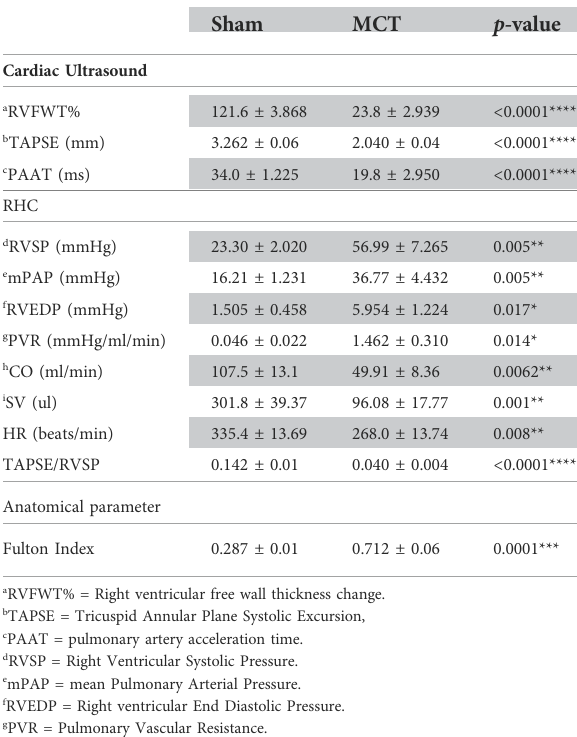
TABLE 1 Haemodynamic assessment of sham Sprague Dawley rats injected with either PBS (2 ml/kg; n = 5) or monocrotaline (60 mg/kg; n = 5) in order to induce pulmonary arterial hypertension